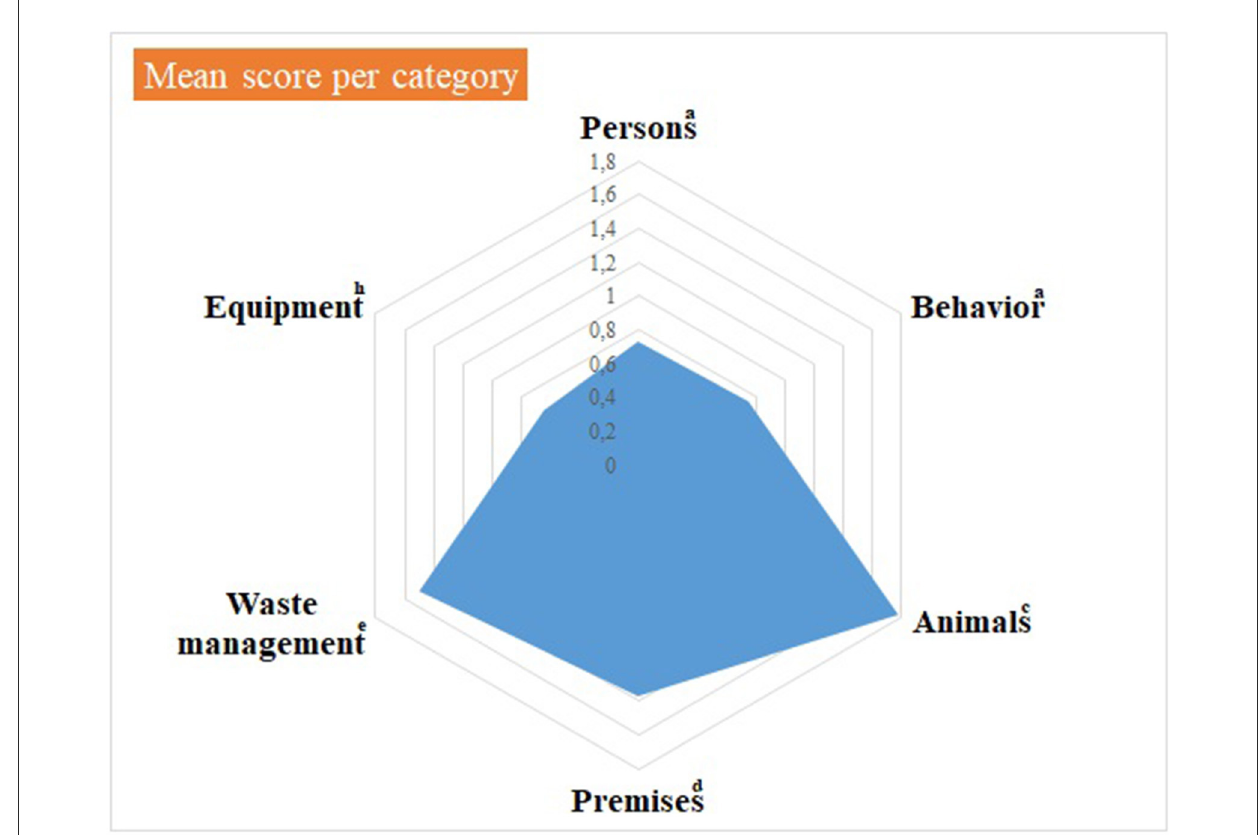
FIGURE1 Illustration of the mean score, per category of items, of the internal biosecurity audit performed in the Class 3 of the Equine Clinic. a For the categories “Persons” and “Behavior”, the number of observations ( = the number of people observed per category, i.e. students, scientific staff members and stable staff members) was 7–10 students of 2nd and 3rd master in veterinary medicine (GVM2 and GVM3), 10–12 scientific staff members and 3 stable staff members. c For the category “Animals”, the number of observations was: animals/boxes = 1, consultation = 1, feeding habits = 1 and animal movements = 7. d For the category “Premises”, the number of observations was: boxes = 7, cleaning order = 1, hand hygiene = 5, boot cleaning = 1, foot baths/mats = 5, doors = 1–5, cleaning equipment = 1 and procedure of cleaning and disinfection = 1. e For the “Waste management” category, the number of observations ( = number of waste equipment present in the facilities) was 9. h For the “Equipment” category, there was one observation, i.e. the procedure in force for cleaning and disinfecting. The number of observations per item appears in Supplementary material